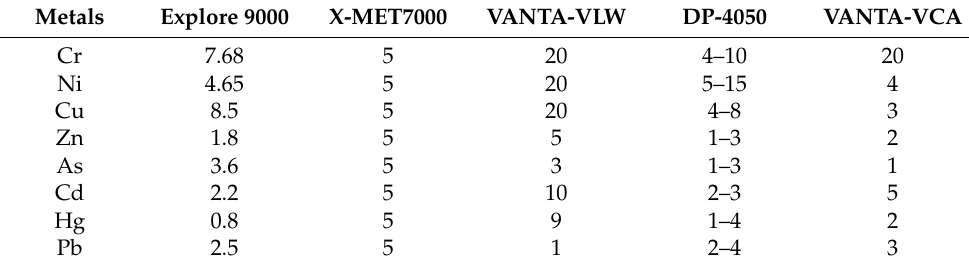
Table 1. Limits of detection (LODs) of each pXRF instrument